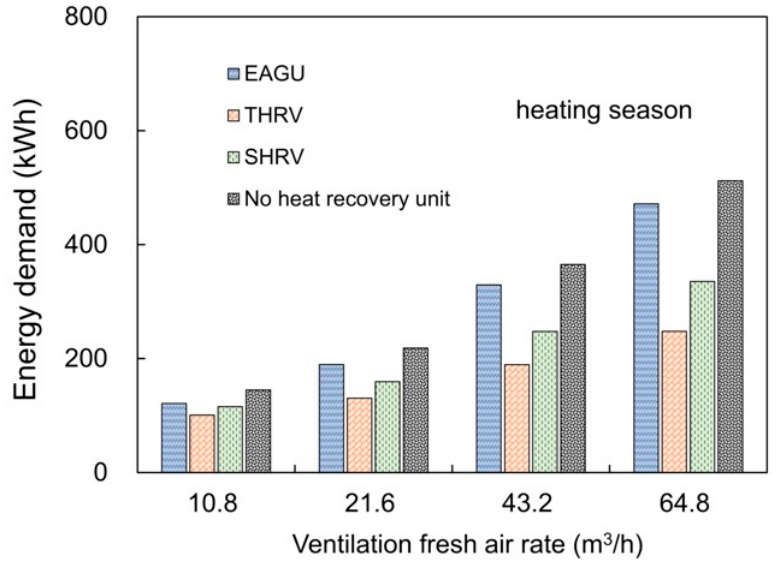
Figure 12. Effect of the ventilation fresh air rate on energy demand of the four cases in the heating season.